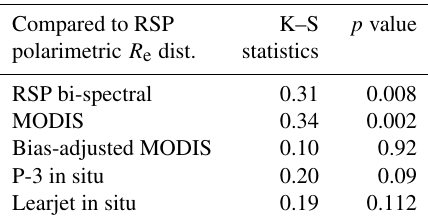
Table 6. Kolmogorov–Smirnov test for similarity statistics, using the RSP polarimetric R e distribution as a